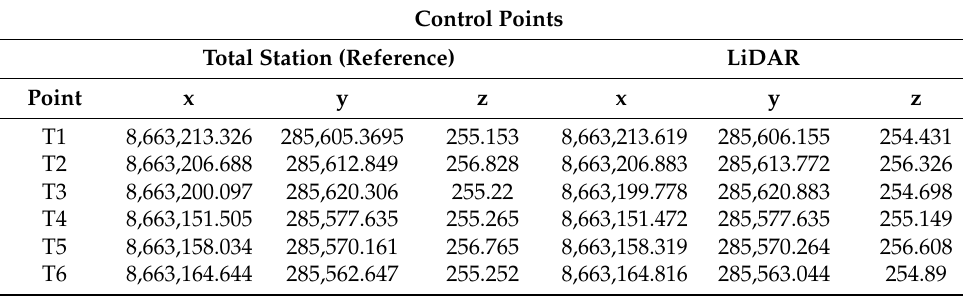
Table 9. Corrected control point coordinates.